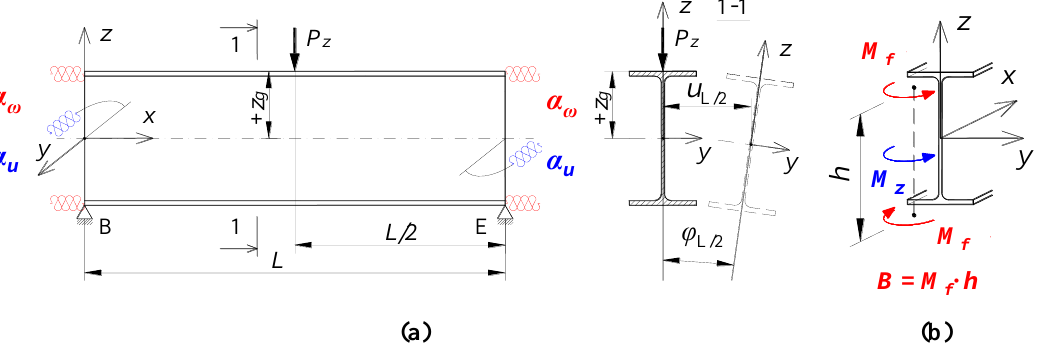
Figure 5. The designated critical beam B–E of the SBG of H-type: ( a ) static diagram and boundary conditions, ( b ) bimoment B and moment M z at the support nodes [13].